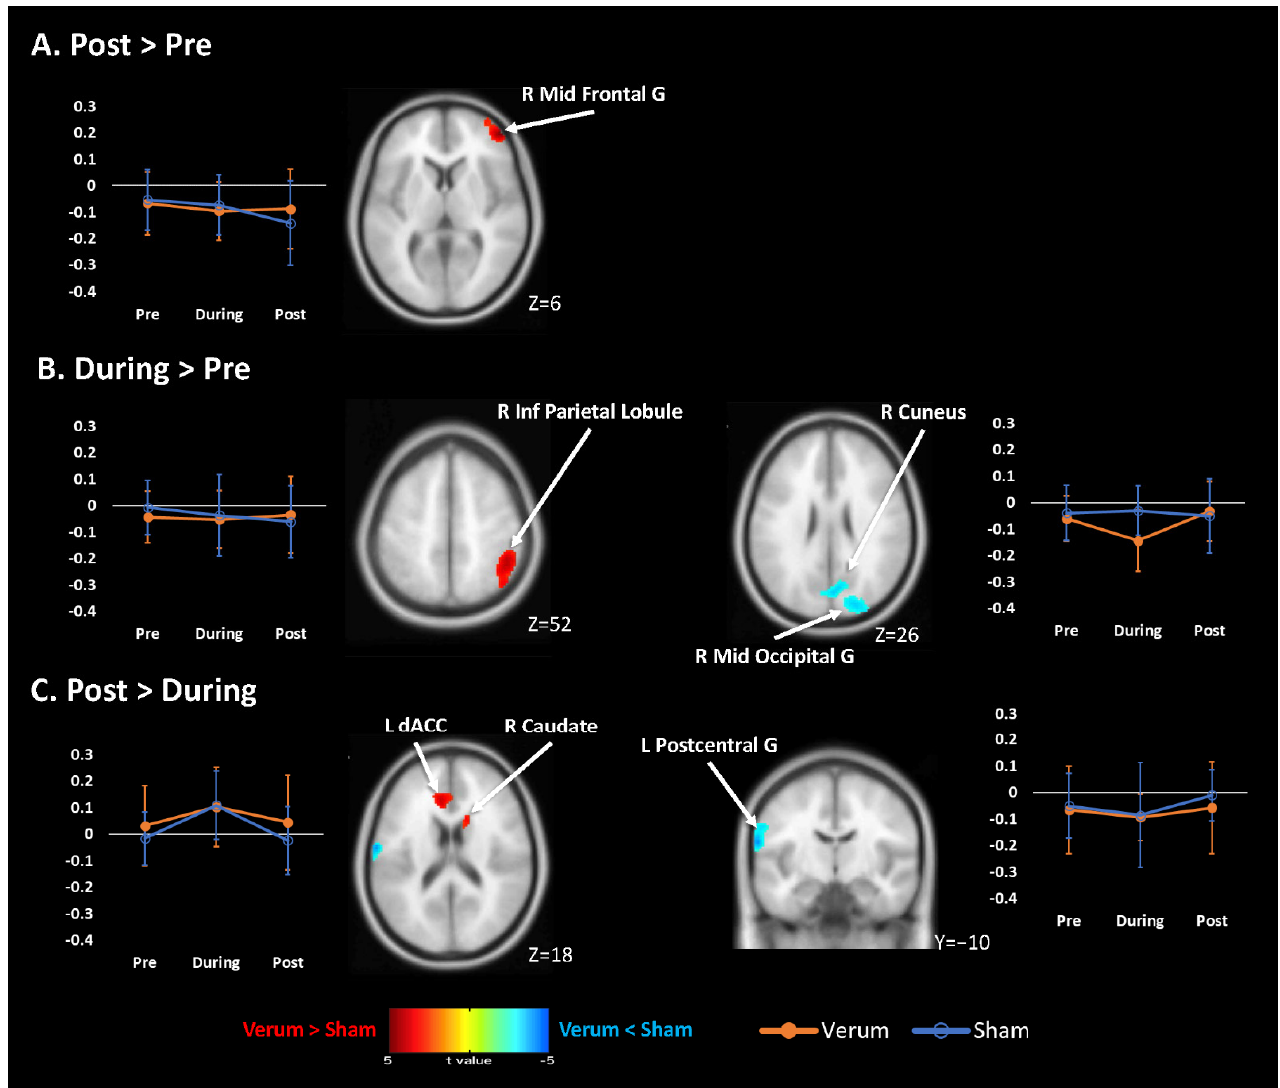
Figure 3. Changes in functional connectivity in descending pain modulation systems between verum and sham acupuncture intervention in patients with primary dysmenorrhea. ( A ) After acupuncture intervention (week 0 to week 8), more increased functional connectivity was found in the right middle frontal gyrus in the verum acupuncture group than in the sham acupuncture group. ( B ) After the early stage of acupuncture intervention (week 0 to week 4), more increased functional connectivity was found in the right inferior parietal lobule in the verum acupuncture group than in the sham acupuncture group, whereas more decreased functional connectivity was found in the right middle occipital gyrus. ( C ) After the late stage of acupuncture intervention (week 4 to week 8), more increased functional connectivity was found in the right dorsal anterior cingulate cortex in the verum acupuncture group than in the sham acupuncture group, whereas more decreased functional connectivity was found in the left postcentral gyrus. Warm and cold colors superimposed on the T1